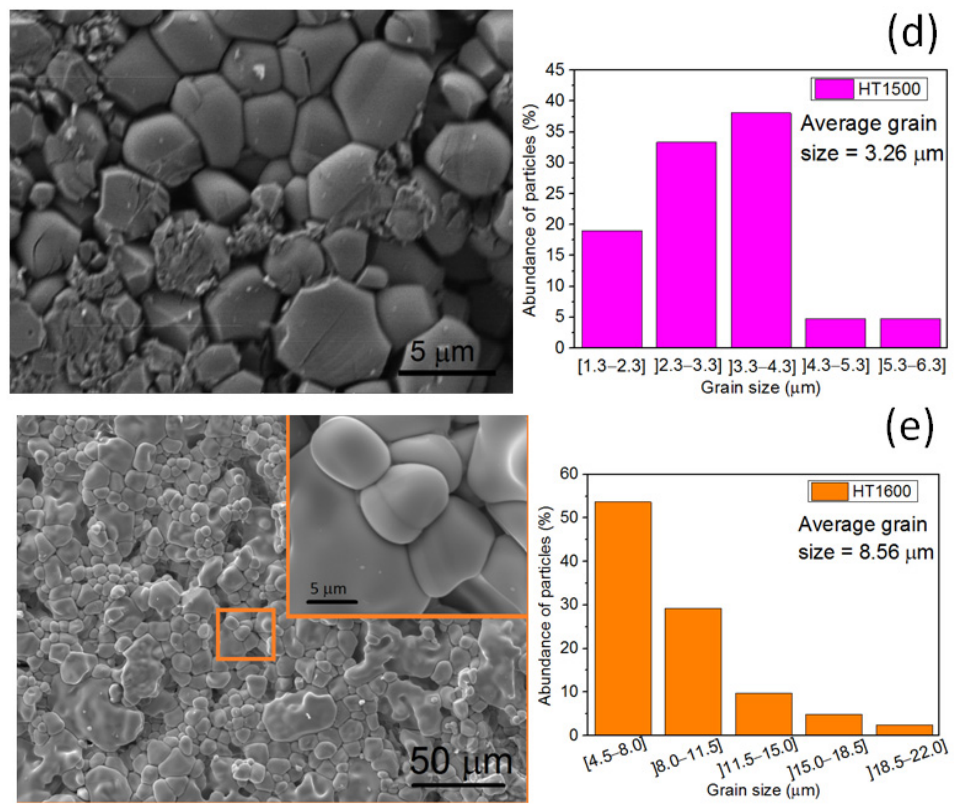
Figure 6. SEM micrographs and grain size distribution graphs of the studied samples: ( a ) HT1100; ( b ) HT1200; ( c ) HT1400; ( d ) HT1500; ( e ) HT1600.